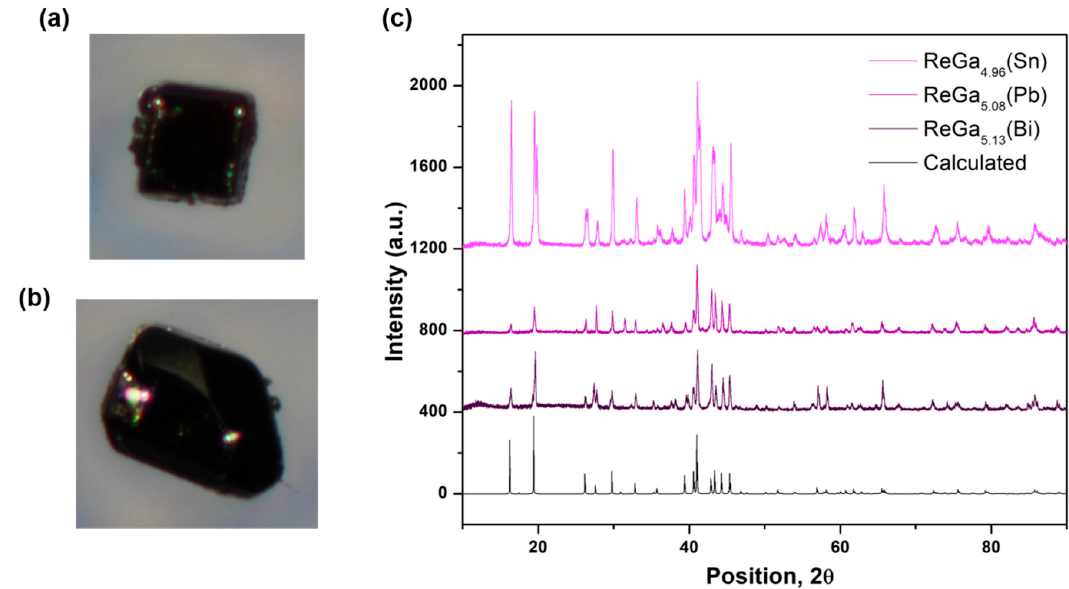
Figure 1. ( a,b ) Pictures of the ReGa ~5 (Sn) single crystals. ( c ) Powder XRD patterns for ReGa ~5 (Sn), ReGa ~5 (Pb) and ReGa ~5 (Bi). Table 1. Single crystal refinement data for ReGa 4.96 (Sn), ReGa 5.08 (Pb) and ReGa 5.13 (Bi).